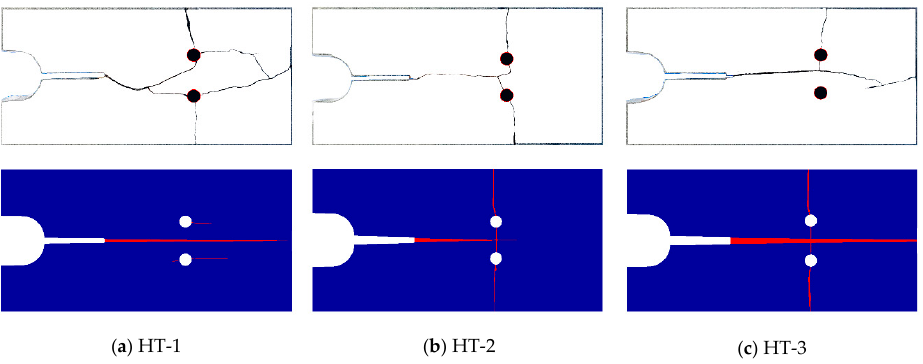
Figure 8. Simulation results of crack propagation paths calculated by AUTODYN. ( a ) Comparison of specimen HT-1 between numerical simulation and experiment. ( b ) Comparison of specimen HT-2 between numerical simulation and experiment. ( c ) Comparison of specimen HT-3 between numerical simulation and experiment.